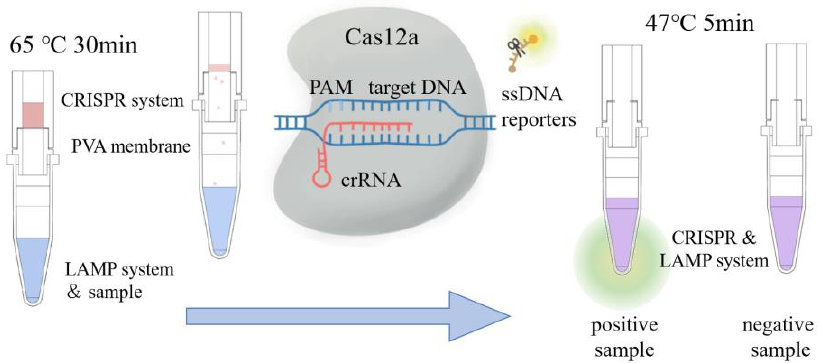
Figure 1. Schematic diagram of visual nucleic acid detection via LAMP-CRISPR reaction with speediness, specificity, and sensitivity.